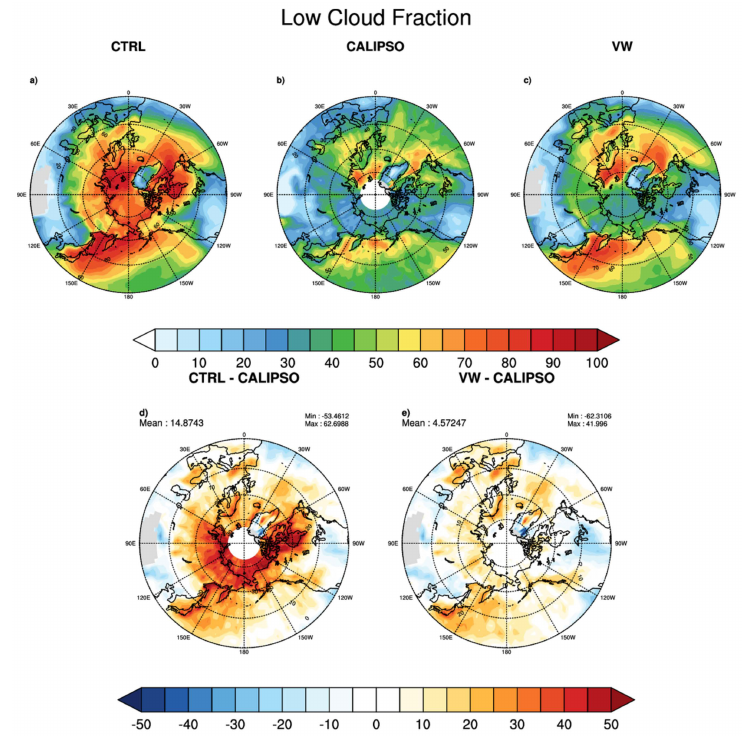
Figure 3. Low cloud Fraction of ( a ) CTRL, ( b ) CALIPSO, ( c ) VW and the biases of ( d ) CTRL and ( e ) VW against CALIPSO-GOCCP observation during winter from 2007 to 2010.